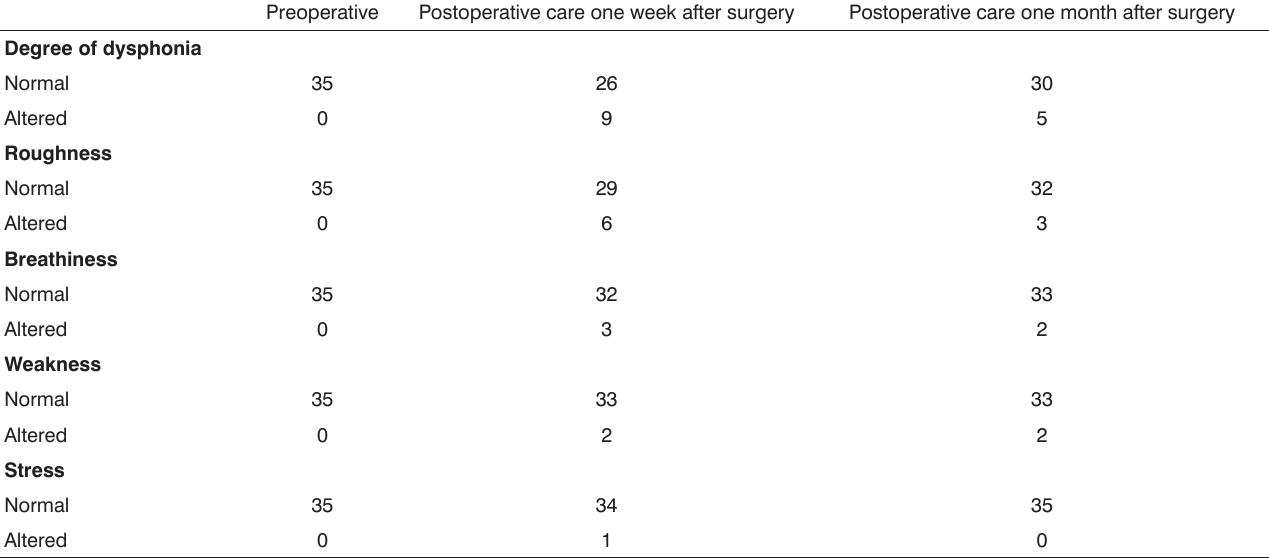
Table 2. Voice perception analysis - preoperative findings and results one week into postoperative care and 30 days after surgery